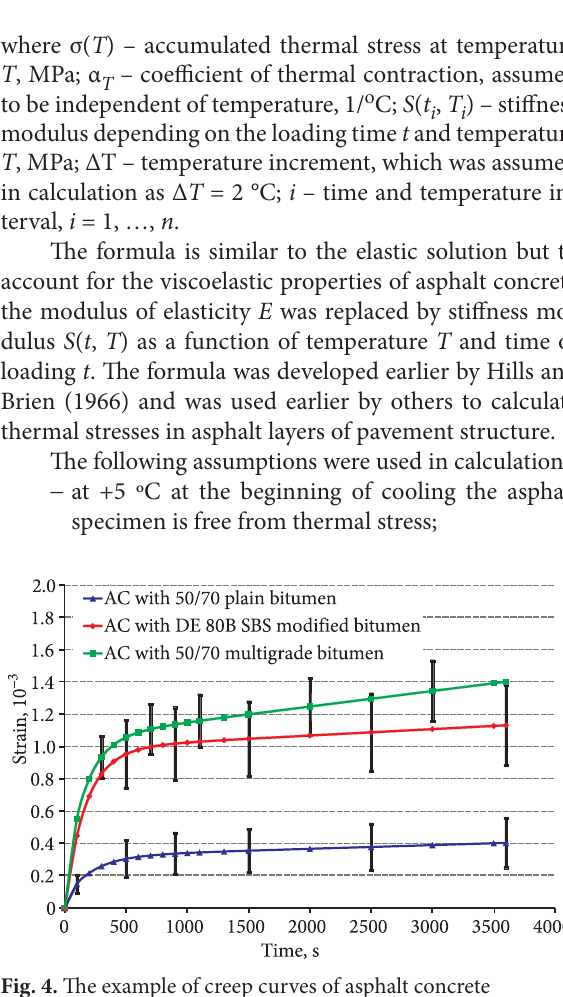
Fig. 4. The example of creep curves of asphalt concrete at temperature –15 °C for three tested types of bitumen